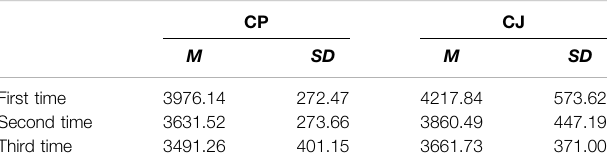
TABLE 4 | Mean response times (ms) and standard deviations ( SD ) in recognition tasks.